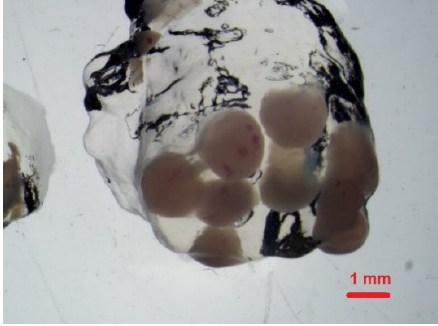
Figure 10. Hybrid MPs in gelatine hydrogel.